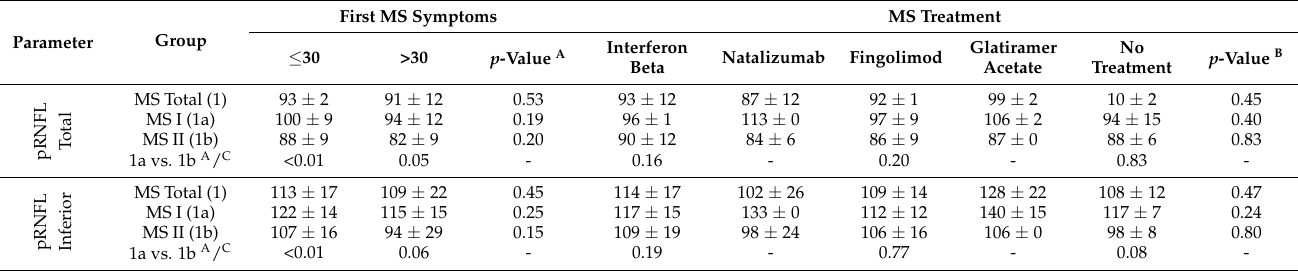
Table 7. Differences in OCT parameters due to groups by MS duration and MS